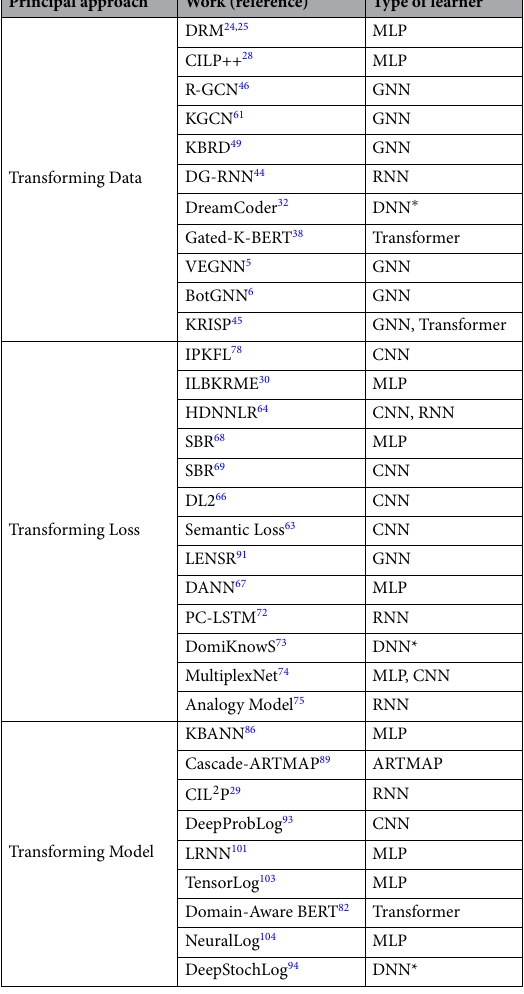
Table 1. Some selected works, in no particular order, showing the principal approach of domain knowledge inclusion into deep neural networks. For each work referred here, we show the type of learner with